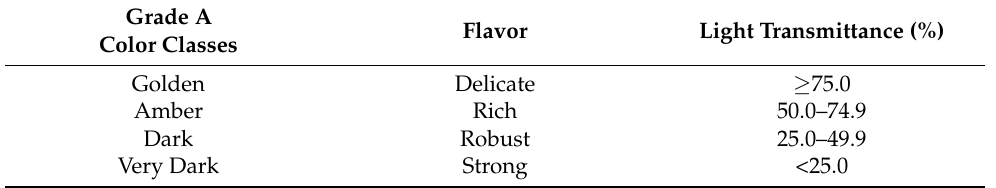
Table 6. “Grade A” color of maple